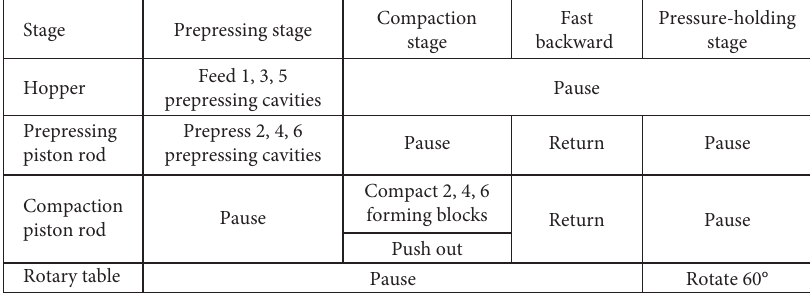
Figure 4: Sequence diagram.